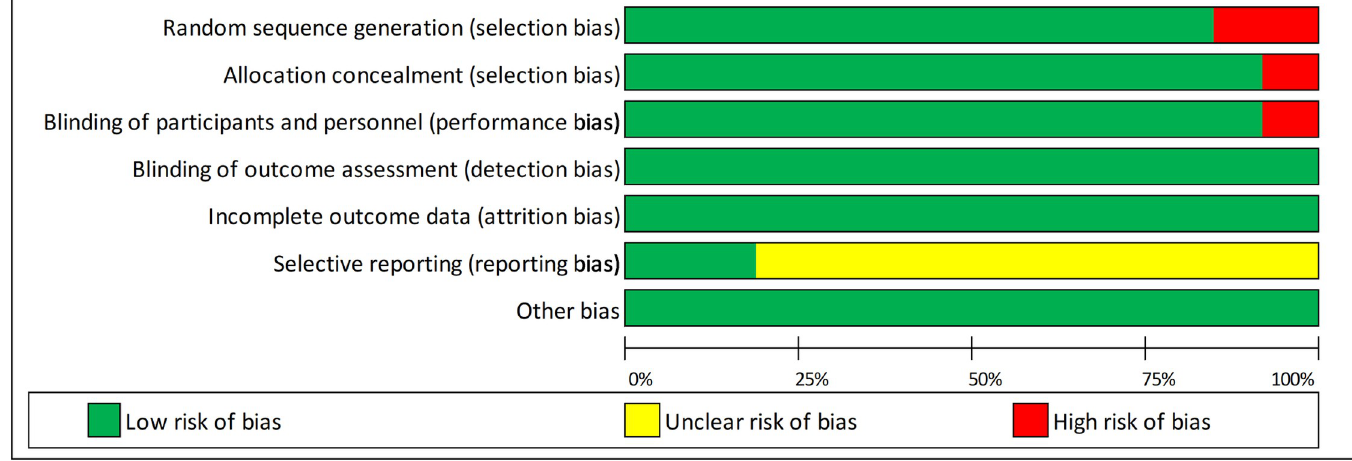
Fig 2. Summary of the risk of bias for selected studies (released under creative commons CC BY SA Robin N. Kok v2.6 November 2017 www.robinkok.eu.